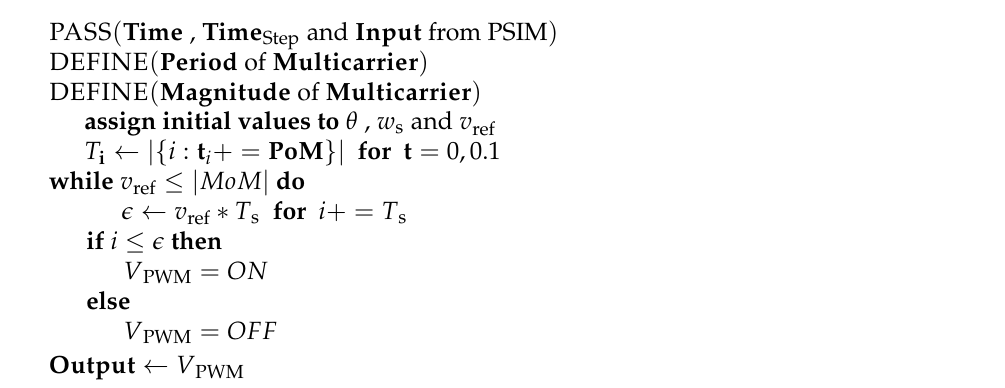
Algorithm 1 Digital implementation of LSPWM